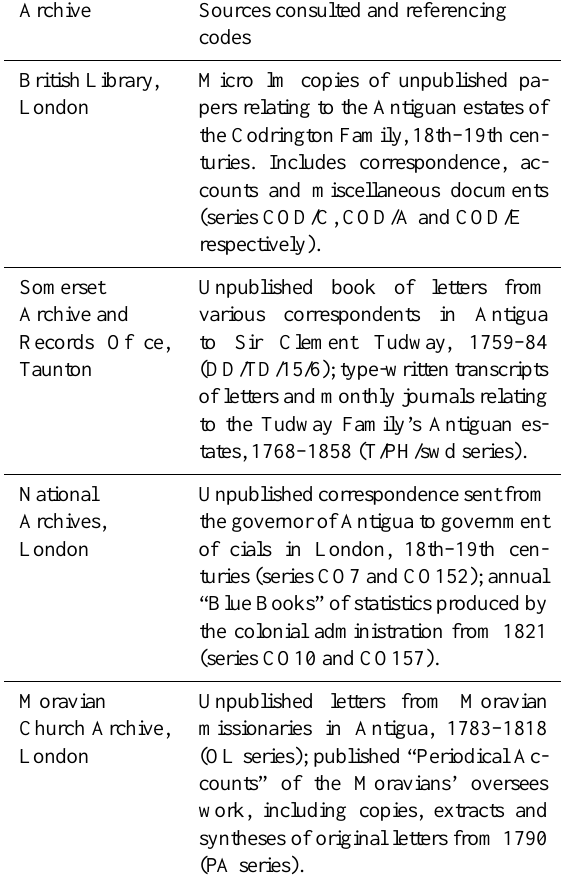
Table 1. Details of archival sources consulted and referencing codes used